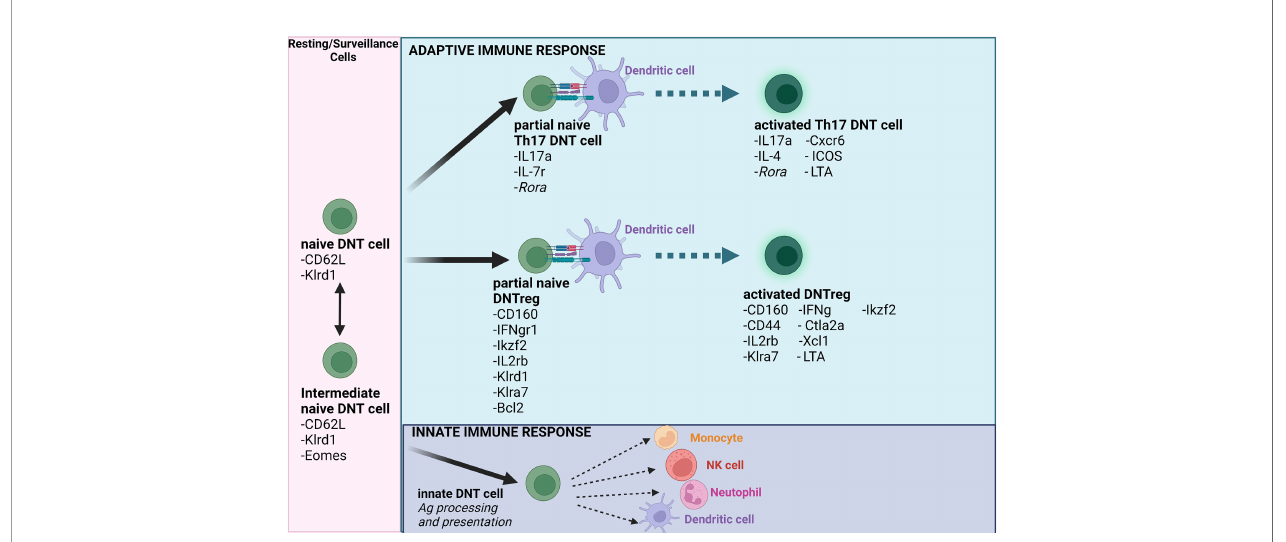
FIGURE 1 | Schematic model of naïve and activated DNT cells. The model summarizes and re fl ects how transitions impact naïve and activated DNT cells (Note- the literature indicates the possibility of several other DNT cell subsets). Importantly, DNT cells can modulate innate and adaptive immune cells based on immune- modulatory status or the prevailing condition in the tissue microenvironment. Ag = antigen. Figure created using Biorender.com